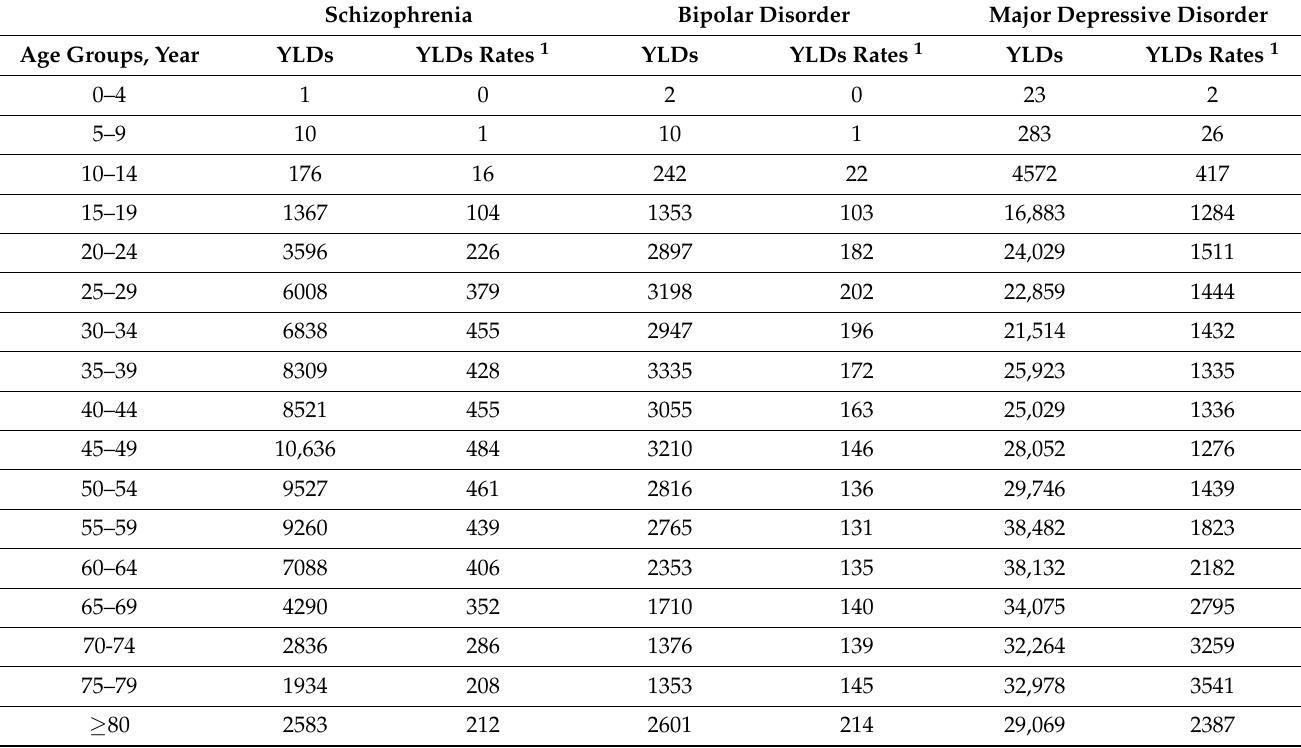
Table 6. Prevalence-based approach YLDs and YLD rates for major psychiatric disease among females by